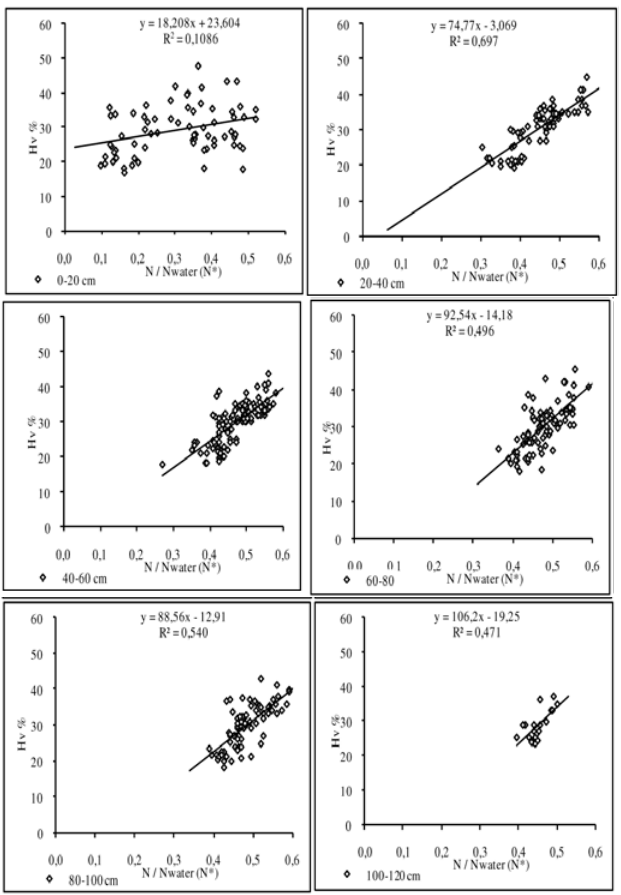
Fig. 2 - Probe calibration curves determined for the neutron SOLO 25 for different soil layers. Gravimetric measurements (H correlated to the counting ratio N*= N/N referred to counting made into the soil and water, respectively.